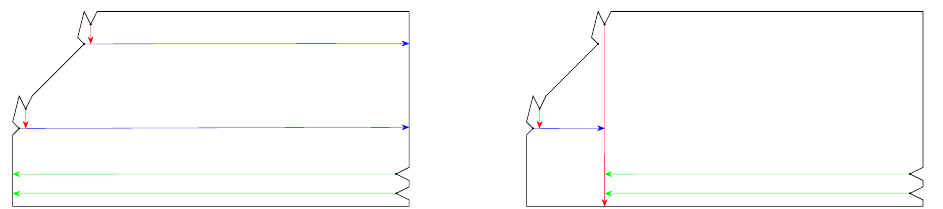
Figure 8. Polygon angles can be adjusted such that removal of any of the Θ ( n ) blue motorcycles unblocks its associated red motorcycle, which in turn blocks the Θ ( n ) green motorcycles.